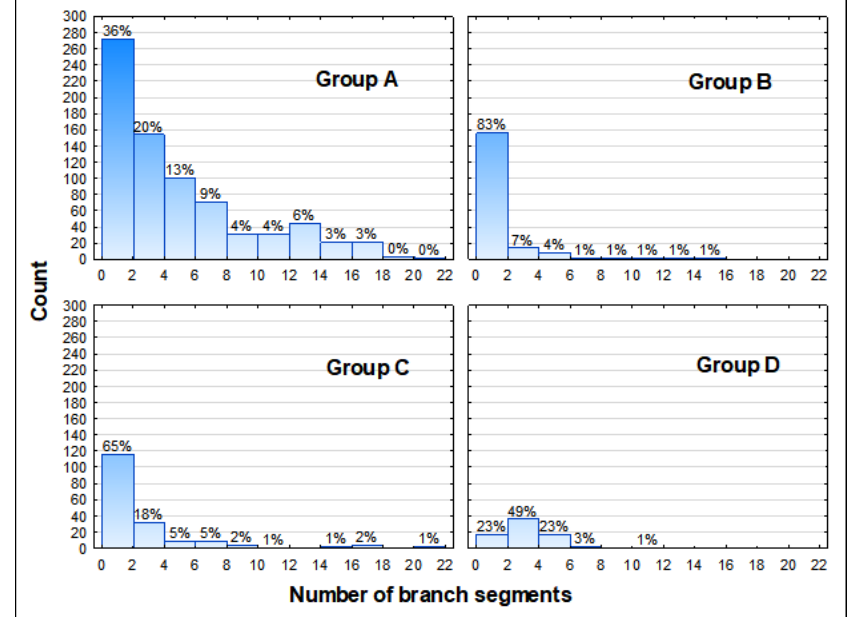
Figure 7. Histograms of the age structure of inventoried groups described by the number of branch sections. Group A is the Jabal Samhan population, B and C are populations located at the eastern parts of Jabal al Qamar, and group D is located at the western part of Jabal al Qamar. Of Jabal al Qamar’s population, 552 individual trees were recorded and measured: 308 were healthy trees, 131 were damaged trees, and 113 were dead trees (Figure 8a,b). The average age described by the number of branch segments was 2.8 BS, with a maximum of 22 BS, and minimum of 0 BS. According to these values, we can consider the population to be young. The age structure is described in Figure 7.